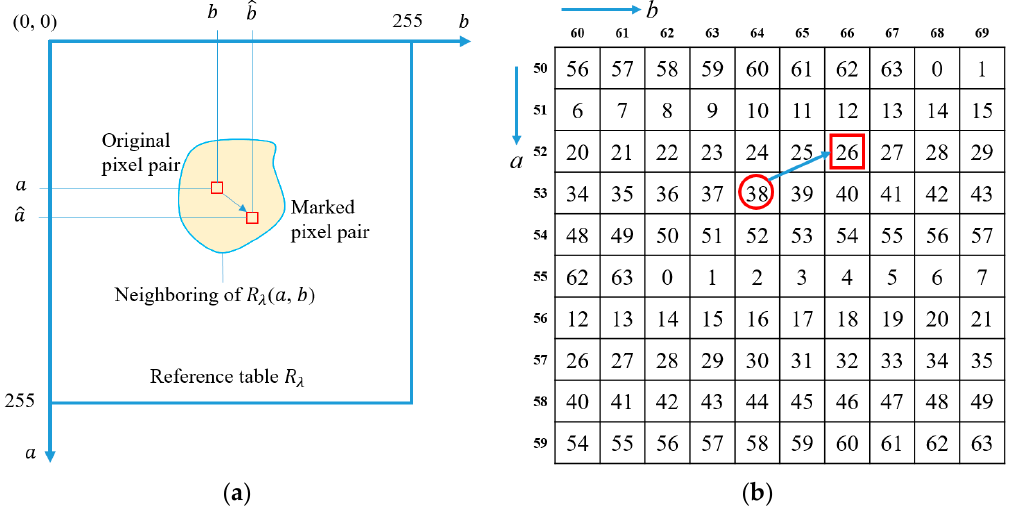
Figure 1. The examples of APPM embedding method. ( a ) The schematic diagram of the APPM; ( b ) An example of R 64